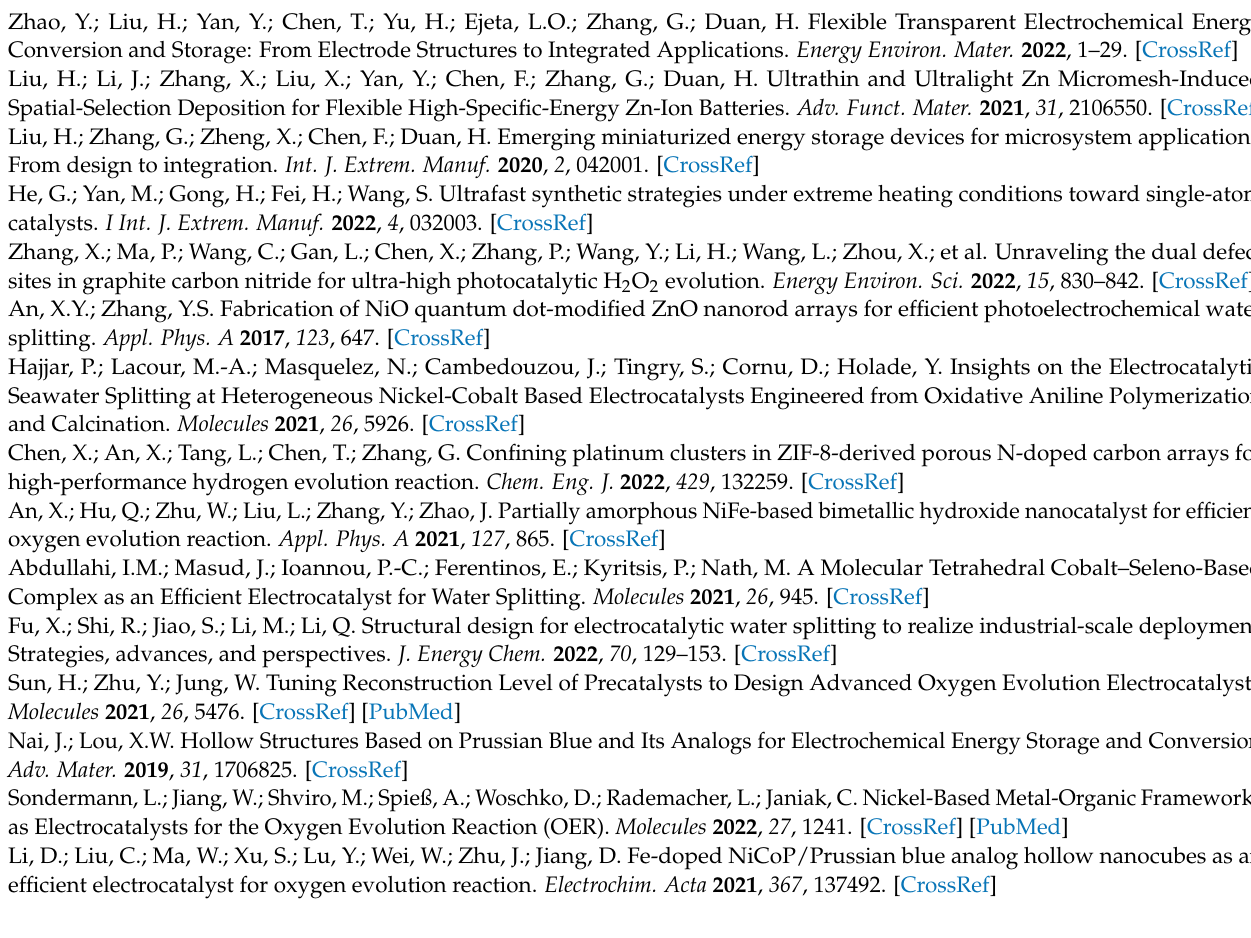
PBA materials; Figure S3: the XPS survey spectra of PBA materials before OER tests. (a) PBA NiFe 2-1; (b) PBA NiFe 2-1/rGO; Figure S4: CV curves of as-obtained PBA materials at different scan rates in non-Faraday potential range. (a) PBA NiFe 0-1; (b) PBA NiFe 1-1; (c) PBA NiFe 2-1; (d) PBA OER measurement. High-resolution Ni 2p and Fe 2p spectra of PBA NiFe 2-1, respectively; Table S1: catalyst performance of analogous materials; Table S2: the calculated C dl ECSA values of as-obtained PBA materials. References [17–19,43,44] are cited in Supplementary